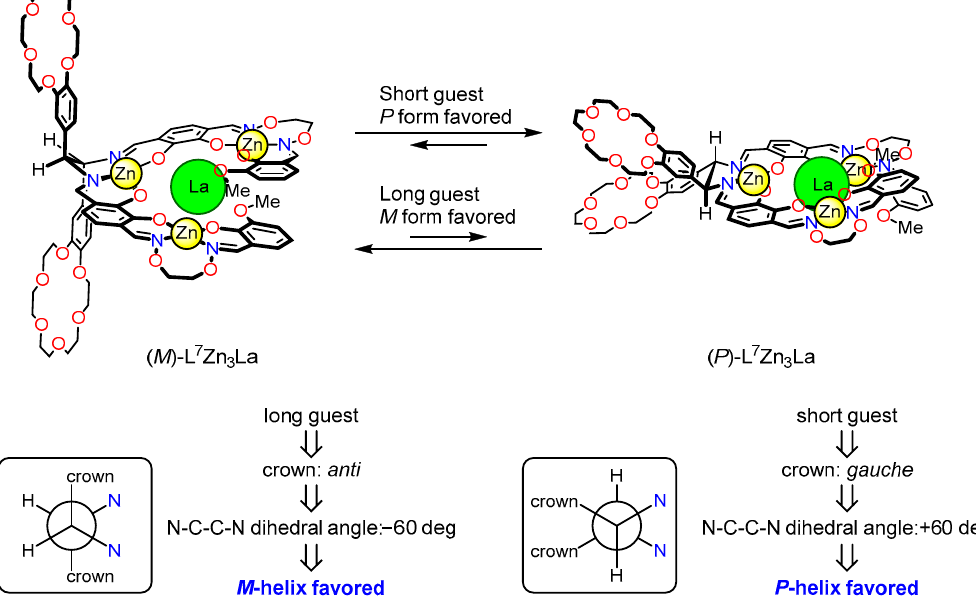
Figure 17. Molecular design of helical complex L 7 Zn 3 La having two crown units for predictable helicity control and inversion based on chiral salen structure.